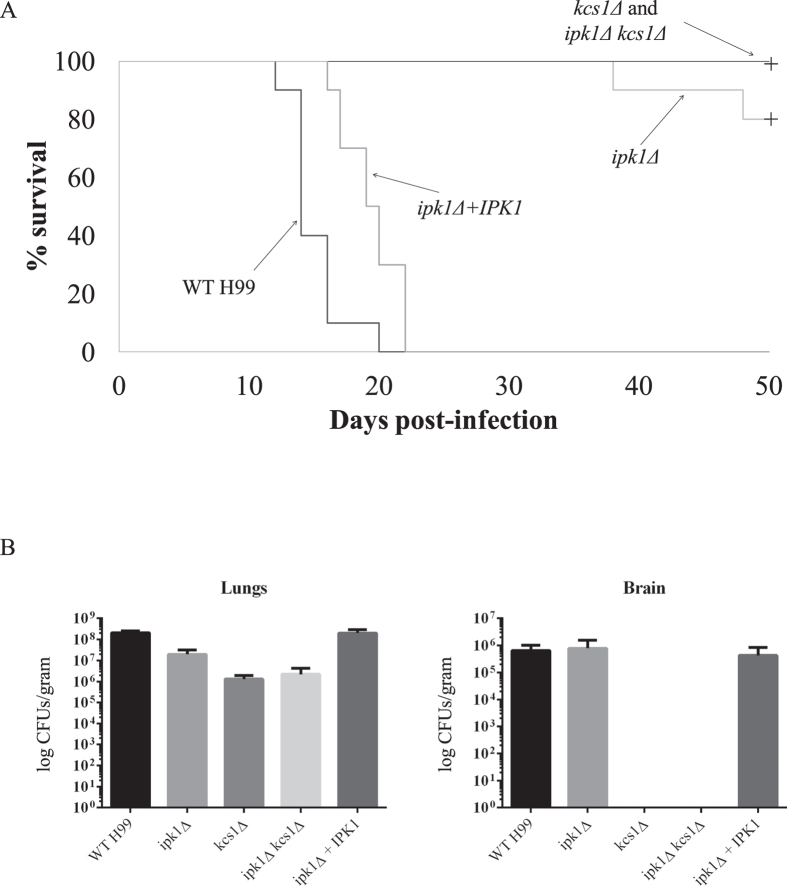
Effect of IPK deletion on virulence in a murine inhalation model of cryptococcosis.(A) Survival analysis. Isoflurane-anaesthetised mice were inoculated intranasally with 5 × 105 CFUs of WT, ipk1Δ, kcs1Δ, ipk1Δ kcs1Δ and ipk1Δ+IPK1, and euthanised after showing debilitating symptoms of infection, or at 50 days post-infection for asymptomatic mice (see Methods). A survival analysis (Kaplan-Meier log rank test) revealed statistically significant differences in survival between the mutant groups and both WT and ipk1Δ+IPK1 (p < 0.001). Median survival of mice infected with WT H99 and ipk1Δ+IPK1 was 14 and 19 days, respectively, but the difference was not statistically significant (p > 0.05). Note that similar to kcs1Δ-infected mice23 all ipk1Δ kcs1Δ-infected mice were healthy with no sign of illness or weight loss for up to at least 50 days post-infection. (B) Organ burden analysis. Infection burdens were determined at time of death or upon termination of the experiment (Day 50). For each strain, organs were harvested from 3 mice. Results represent the mean logCFUs ± SEM. The PP-IP4-deficient strains, kcs1Δ and ipk1Δ kcs1Δ, did not disseminate to the brain.